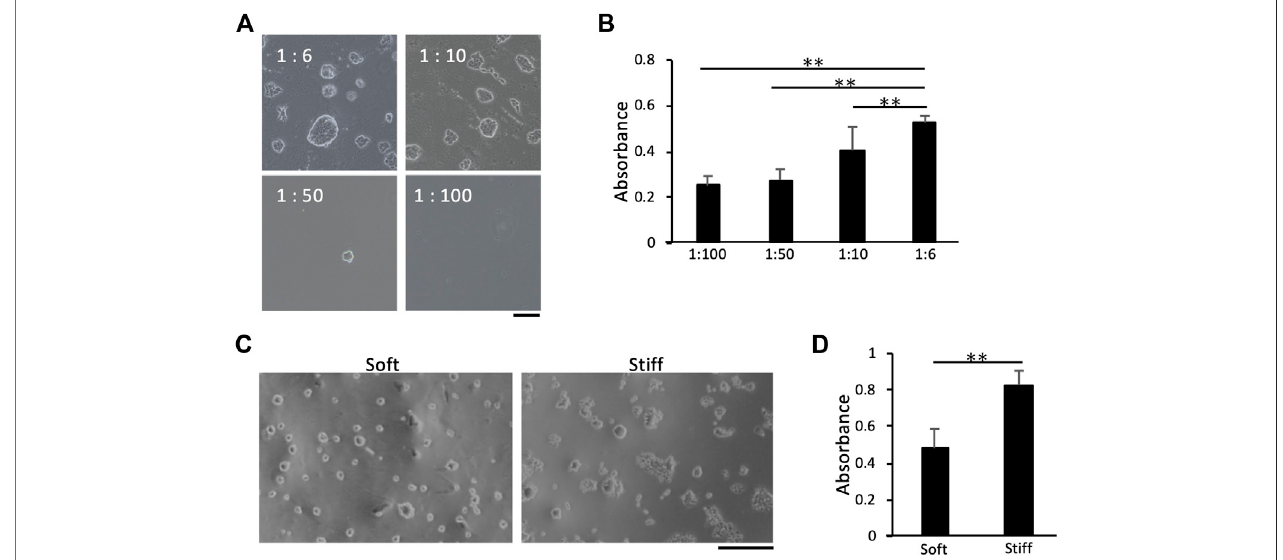
FIGURE 2 | Effects of NHS-AA ester:AA mixing ratios on cell proliferation and adhesion. Cell distribution and proliferation increased with a higher mixing ratio of NHS-AA ester:AA (A) Cells adhered to softer gels (estimated stiffness: 0.48 kPa) made with different NHS-AA ester:AA mixing ratios. Scale bar: 100 µm (B) Cell proliferation on gels made with different NHS-AA ester:AA mixing ratios. (C) Thedistribution ofadherent cells wasuniform on both soft and stiff gels (estimated stiffness: 0.48 and 34.88kPa, respectively) at amixingratio of1:6. Scale bar: 500 µm. (D) Cell proliferation ratewas higher on stiffer gels than on softer ones with 1:6mixing ratios. Each value represents the mean of three independent replicates ± the SD. ** p < 0.01, * p < 0.05.